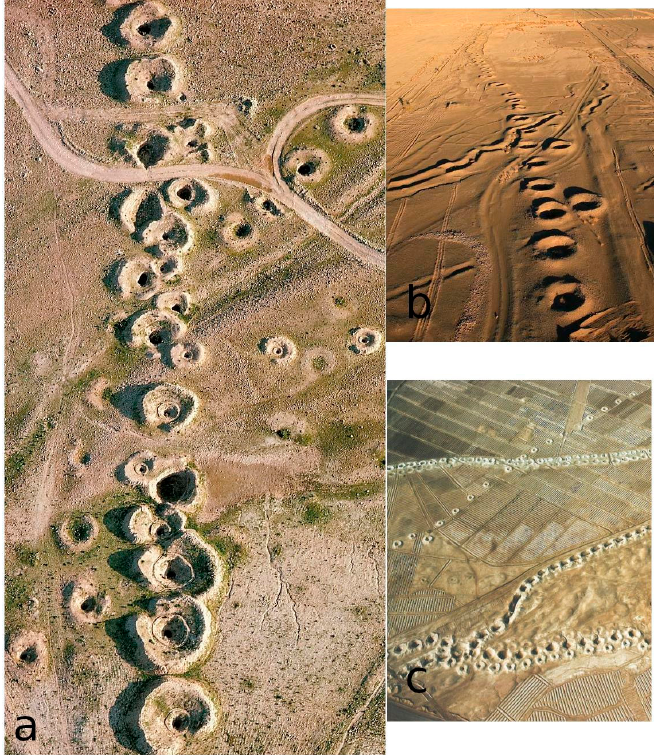
Figure 6. Raw images demonstrating qanats in ( a – c ).